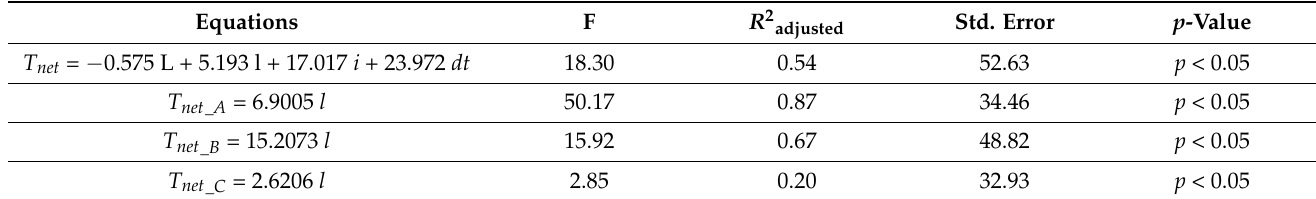
Table 5. Summary of the work cycle time models at the site and corridor level. Equations